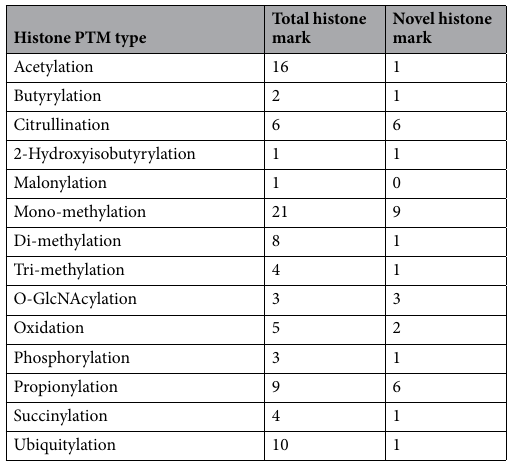
Table 5. Summary of post-translational modifications (PTMs) identified on the core histones in AUY922- and ganetespib-treated bladder cancer 5637 cells. See Fig. 4A and B for